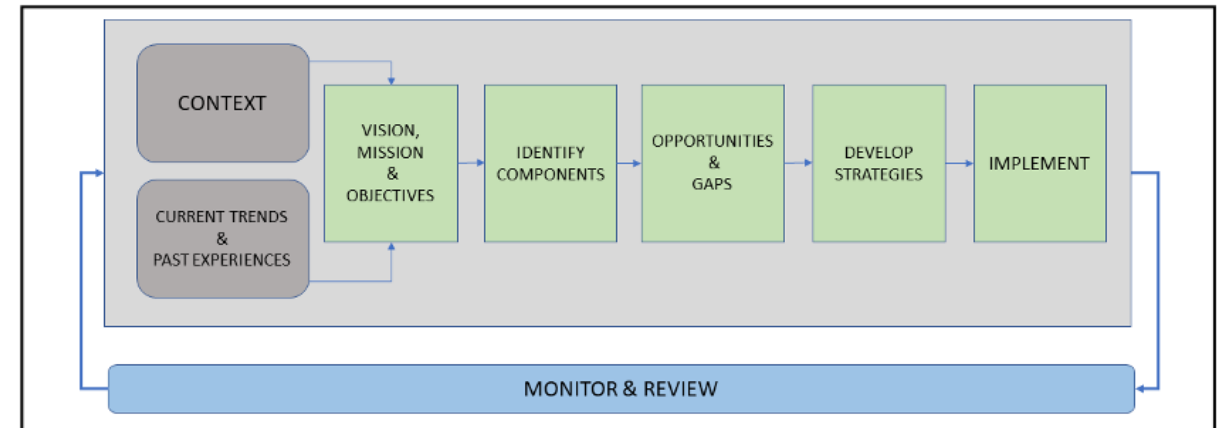
Figure 4. Approach for developing eHealth strategies during